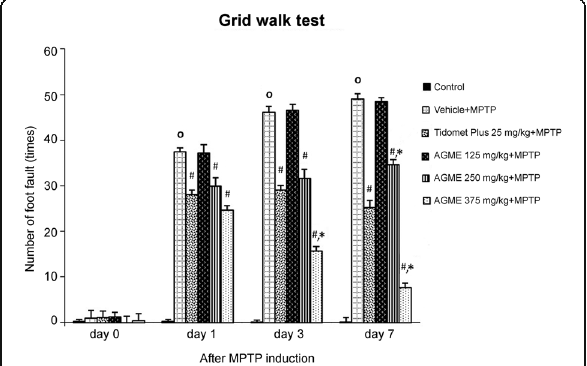
Fig. 2 Effect of AGME on the number of foot faults on the grid walk test at 0, 1, 3, and 7 days after MPTP treatment. Each data column displays the mean ± SD (n = 8/group, o - p < 0.01 compared with the control group; #- p < 0.05 compared with the vehicle-treated group; * -p < 0.05 compared with the Tidomet Plus-treated